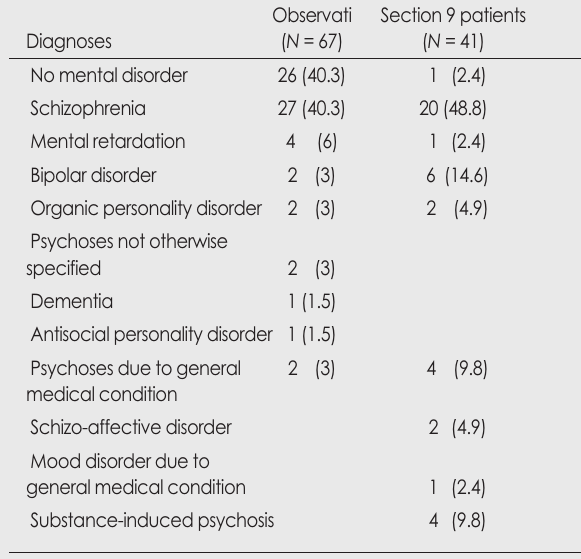
Table II. Comparative diagnoses ( N